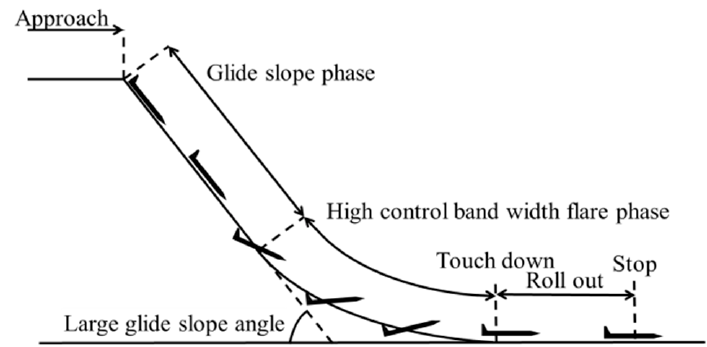
Figure 2. Landing profile.